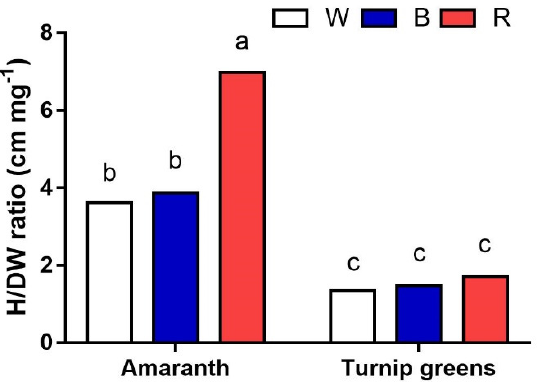
Figure 2. Interaction effect of species × light treatment (W = white, B = blue, R = red) on plant height/dry biomass ratio (H/DW, cm·mg − 1 ) of microgreens. Data are means ± standard error ( n = 3). Three biological replicates were used for the measurements. Different letters indicate significance at p ≤ 0.05 according to Tukey’s test.